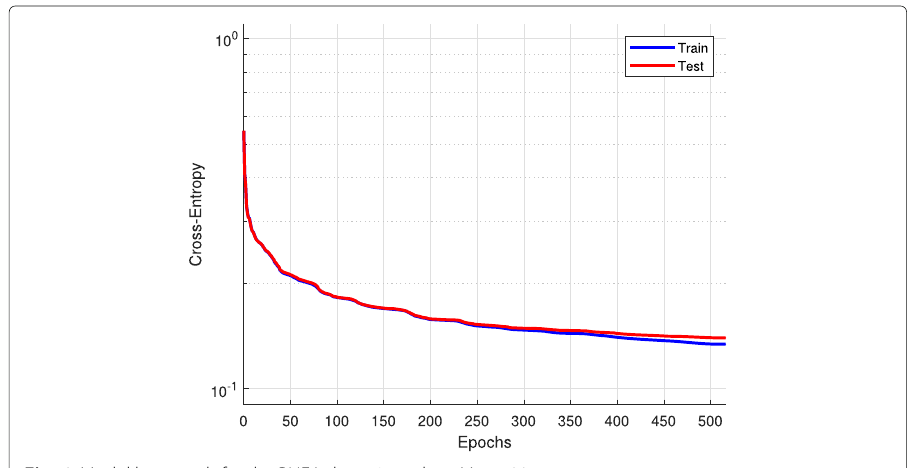
Fig. 6 Model loss graph for the PUEA detection when M =